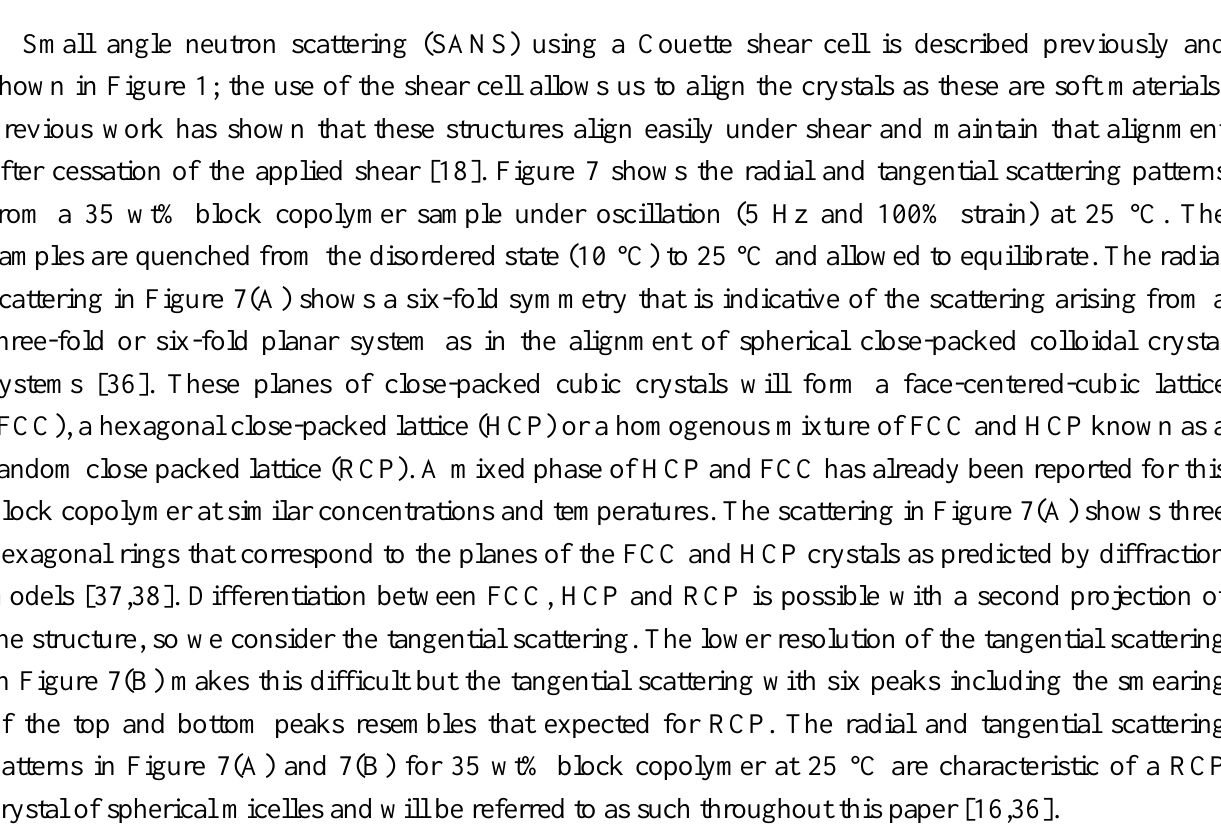
Figure 7. SANS scattering profiles of 35 wt% block copolymer quenched from the disordered state to 25 °C under oscillation (5 Hz and 100% strain). Two dimensional scattering for the ( A ) radial and ( B ) tangential scattering geometry. The color scale runs from blue to red to yellow to white as intensity